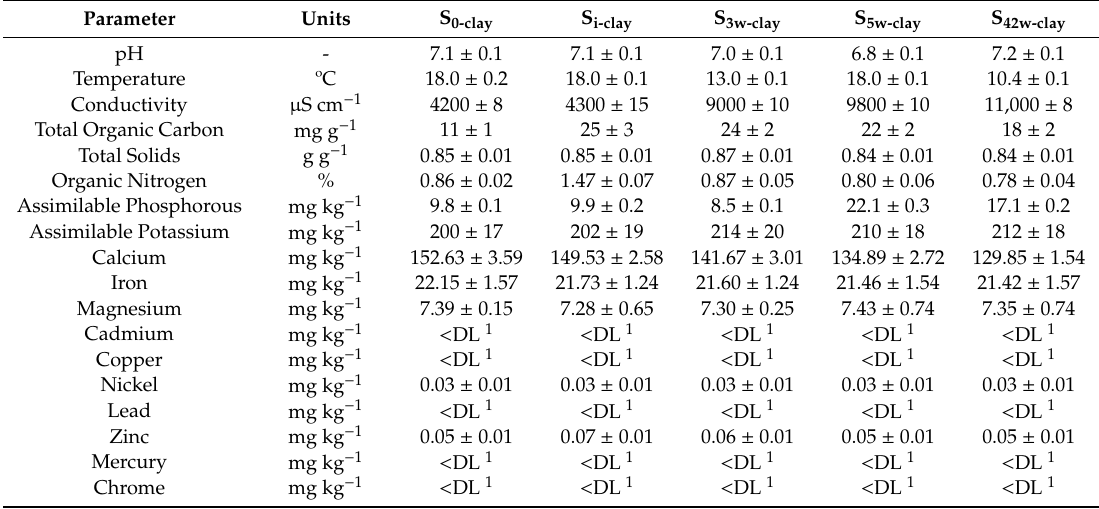
Table 6. Evolution of physical and chemical parameters of clayey soil amended with sewage sludge.